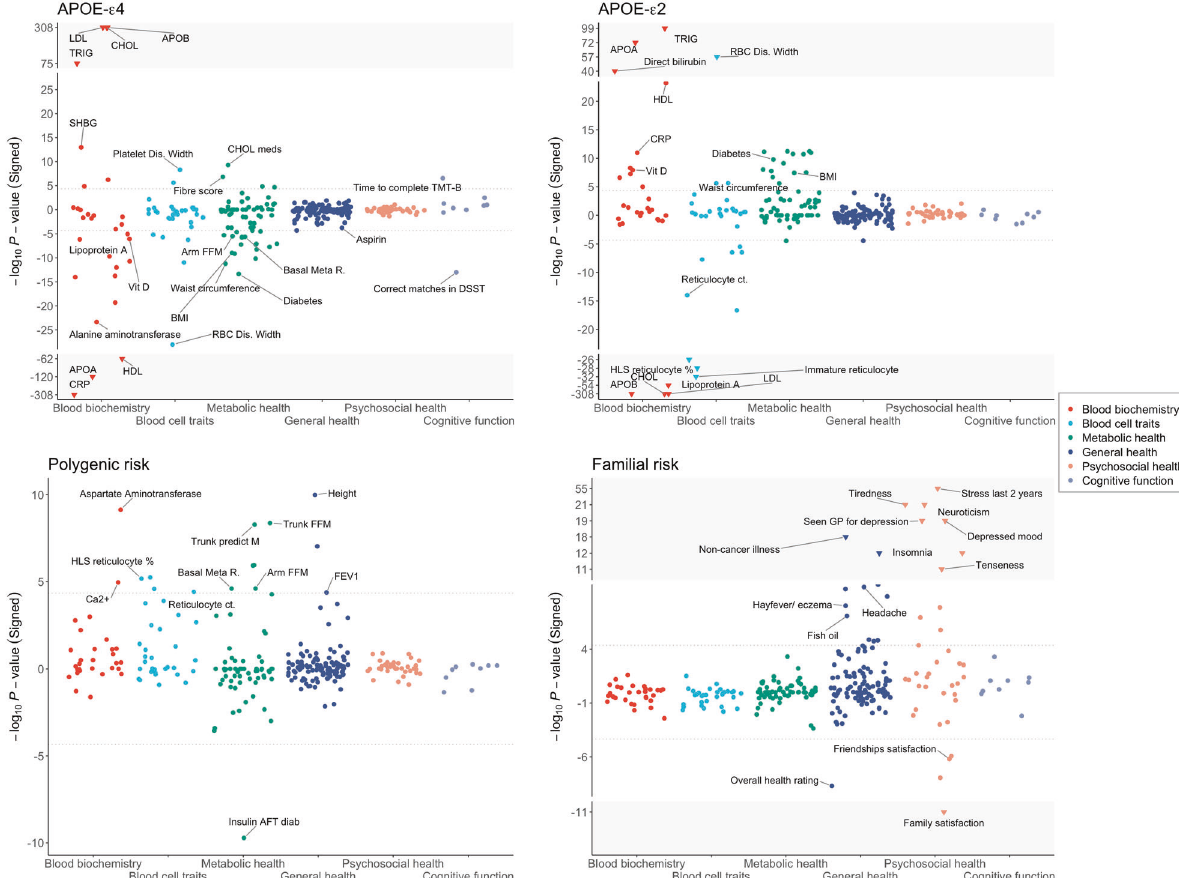
Fig. 1 Associations between APOE- ε 4, APOE- ε 2, polygenic risk (AD PRS) and AD familial risk and 273 traits in the UK Biobank. These association analyses between the genetic risk factors and UK Biobank traits (described in the “ Methods ” section) were controlled for age, age 2 , sex, age*sex interaction term, socioeconomic status based on Townsend deprivation index, genotyping batch, assessment centre, and the fi rst 12 principal components of ancestry, self-reported CVD, statin use, parental CVD and lifestyle score in the models. The grey dotted lines correspond to the P -value signi fi cance threshold ( P < 4.5 × 10 − 5 ; see Methods). The Y -axis has been truncated to show all associated traits to improve visualization, with extreme results shown in the grey area with inverted